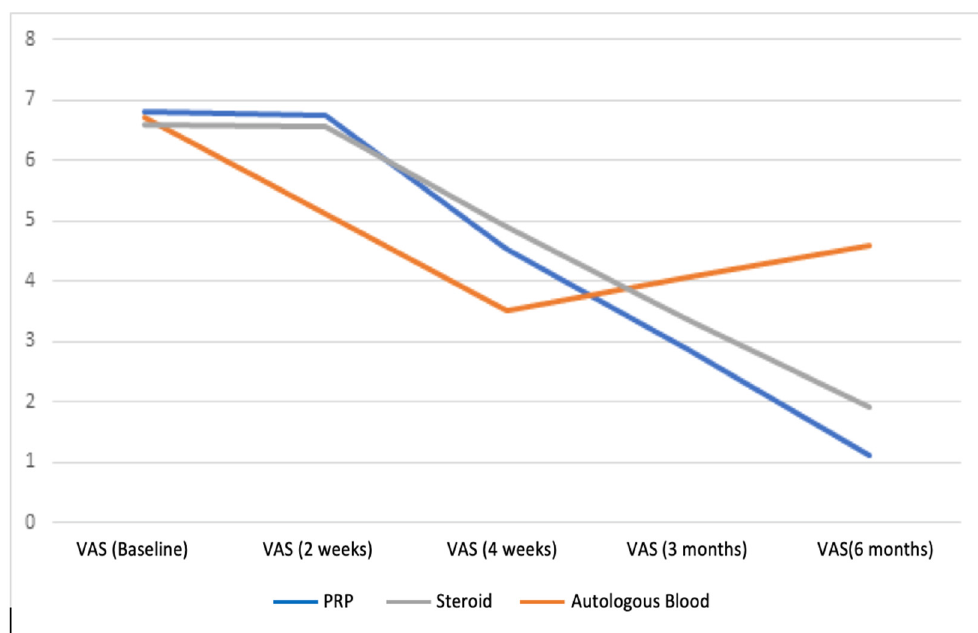
Figure 4. Mean unit improvement in visual analog scale pain score.